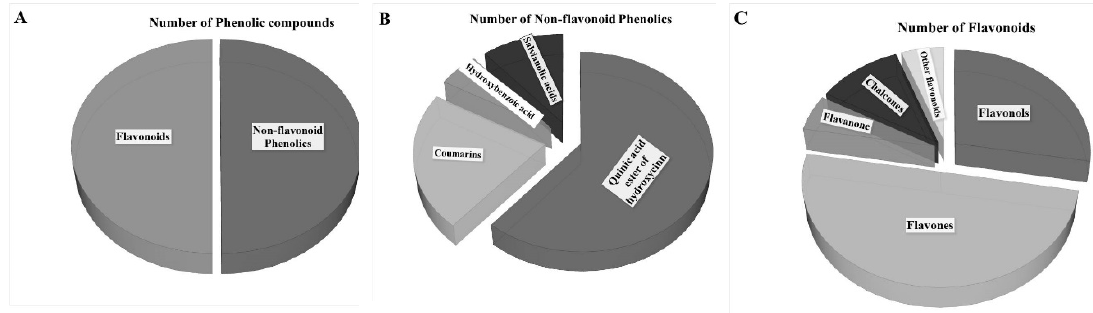
Figure 5. Identified phenolic compounds from Jerusalem artichoke leaf protein concentrate: ( A ) ratio of flavonoid and non-flavonoid phenolic compounds; ( B ) number of identified compounds within non-flavonoid phenolics subgroup; and ( C ) number of identified compounds within flavonoid phenolics